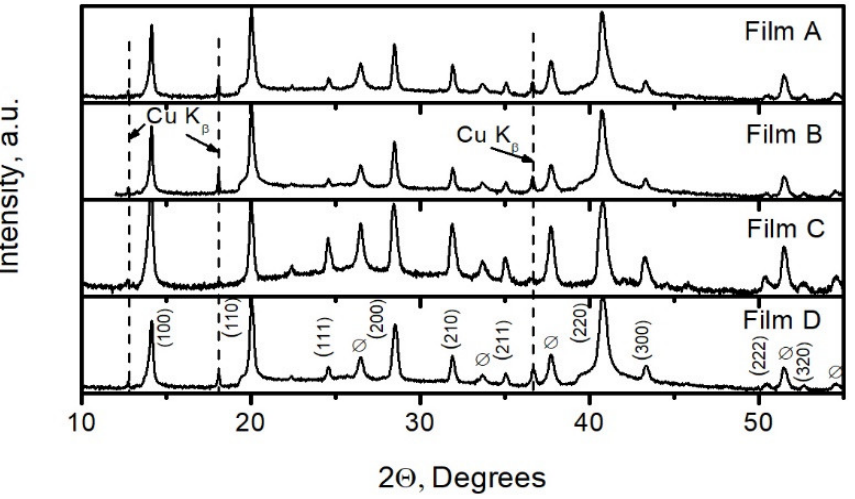
Figure 6. XRD patterns of perovskite films on different titanium dioxide layers: Film A is on the compact TiO 2 layer, Film B is on the mp-TiO 2 layer/c, Film C is on the compact ALD-TiO 2 layer, and Film D is on the ALD-TiO 2 /mp-TiO 2 layer.